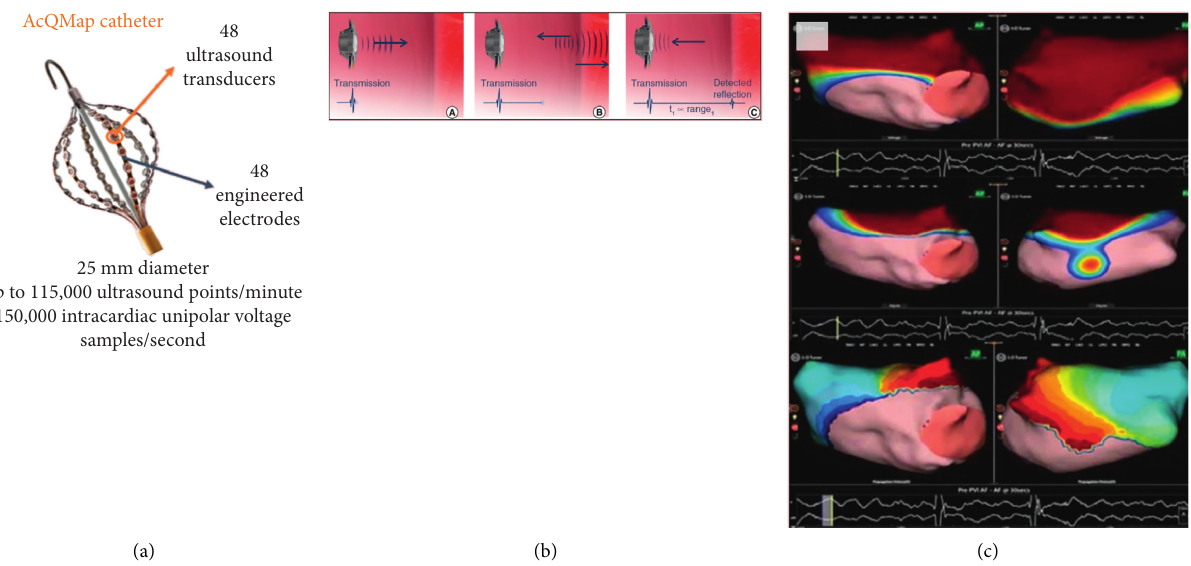
Figure 12: AcQMap noncontact mapping system (Acutus Medical, CA, USA). (a) The multipolar spherical AcQMap catheter with a diameter of 25 mm (deployed), which consists of 6 splines, each of which contains 8 electrodes and 8 ultrasound transducers (total 48). (b) The three-dimensional model of the LA is constructed by emitting ultrasonic waves reflecting them to the cardiac wall. (c) The system displays on the three-dimensional model the propagation of the impulse, calculated by measuring the dipole density.